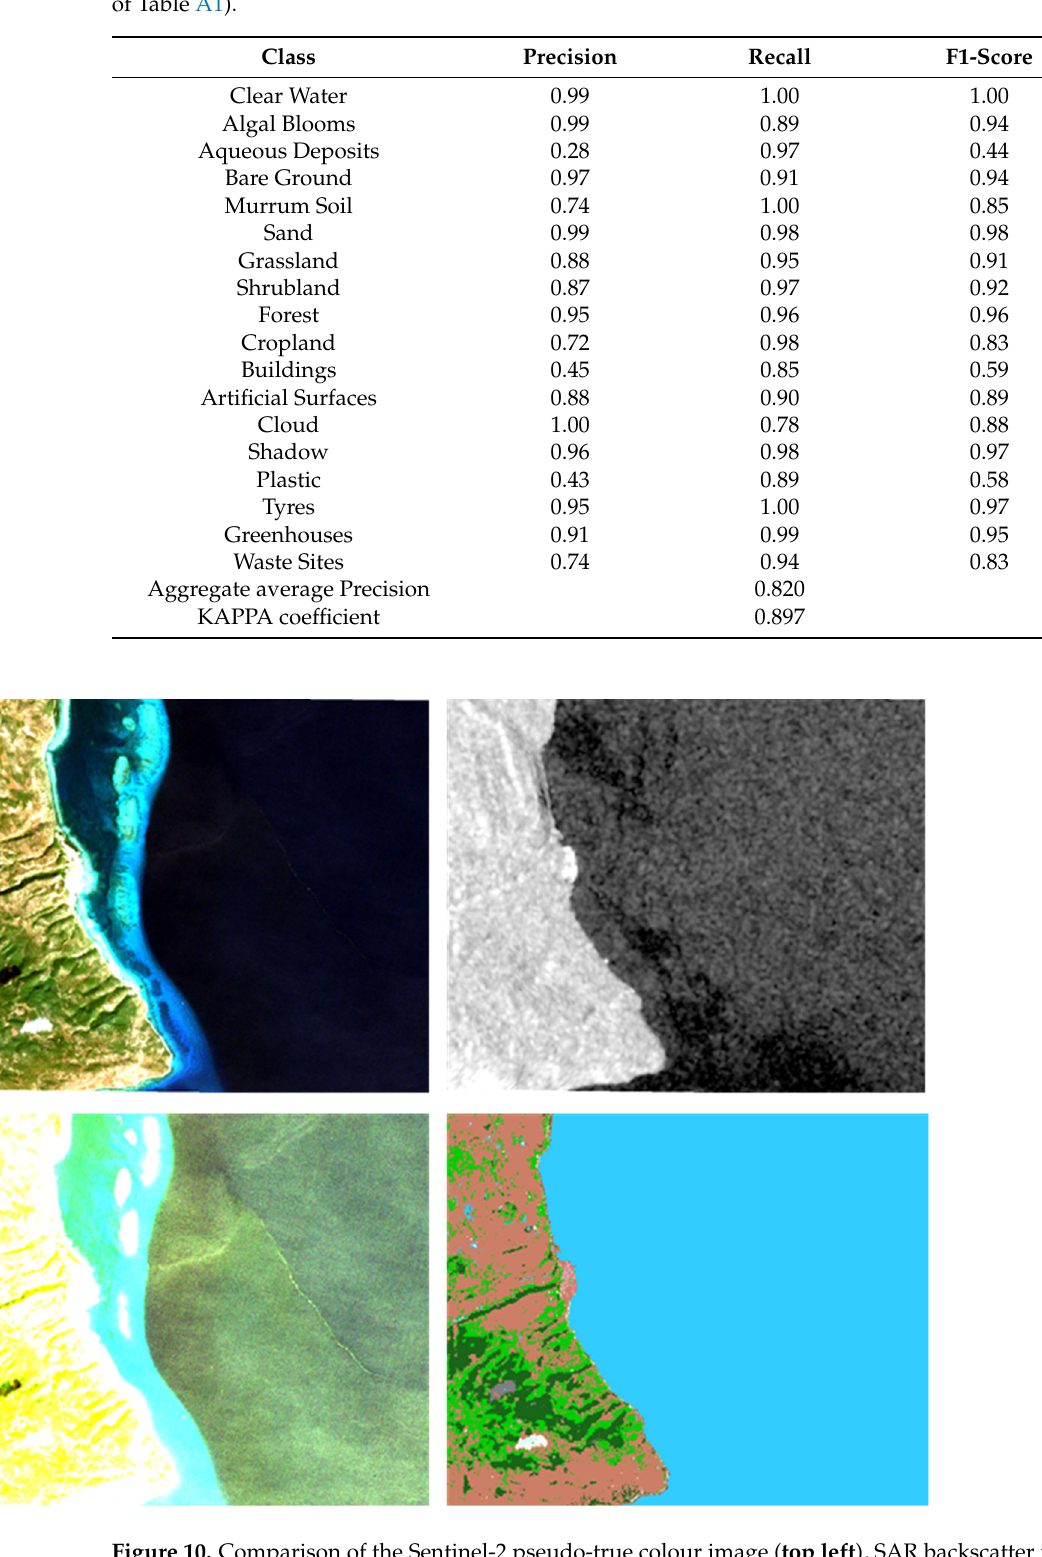
Table 6. Classifier accuracy statistics after the addition of five validation sites (shown at the bottom of Table A1).